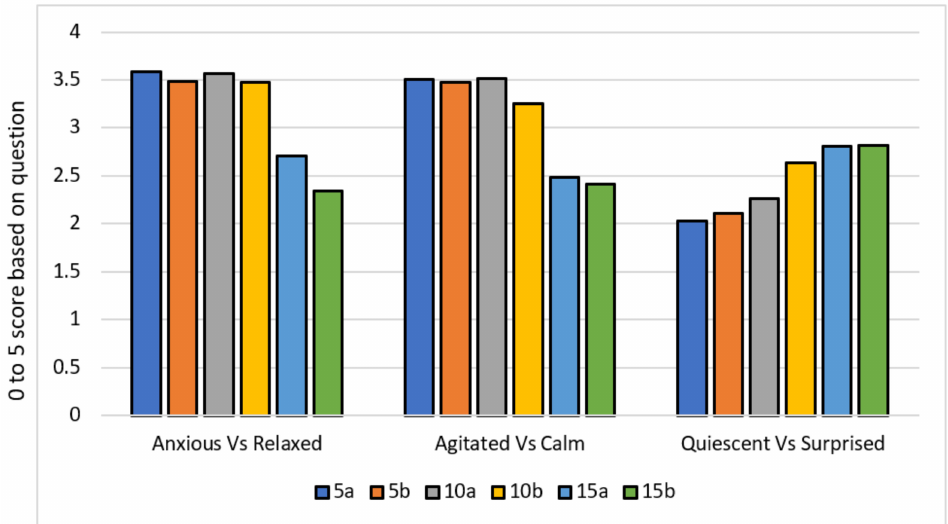
Figure 10. Self-reported feeling for safety for an ego vehicle